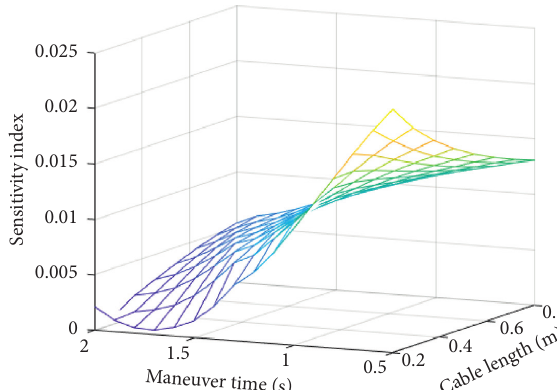
Figure 5: Sensitivity index over different cable lengths and a range of maneuver times.